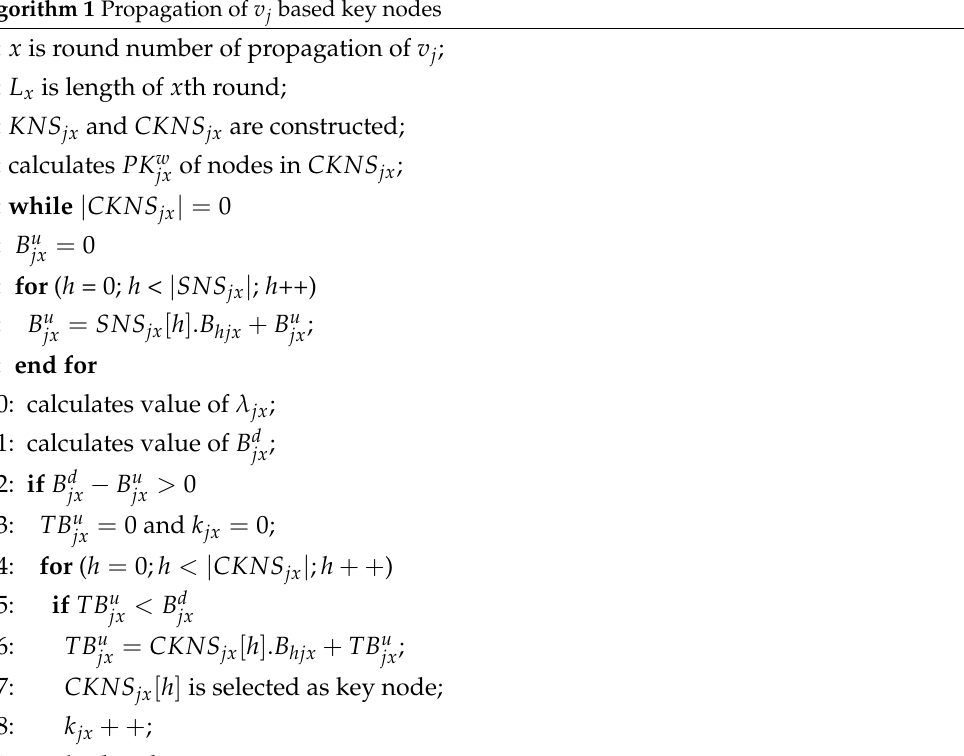
Algorithm 1 Propagation of v j based key